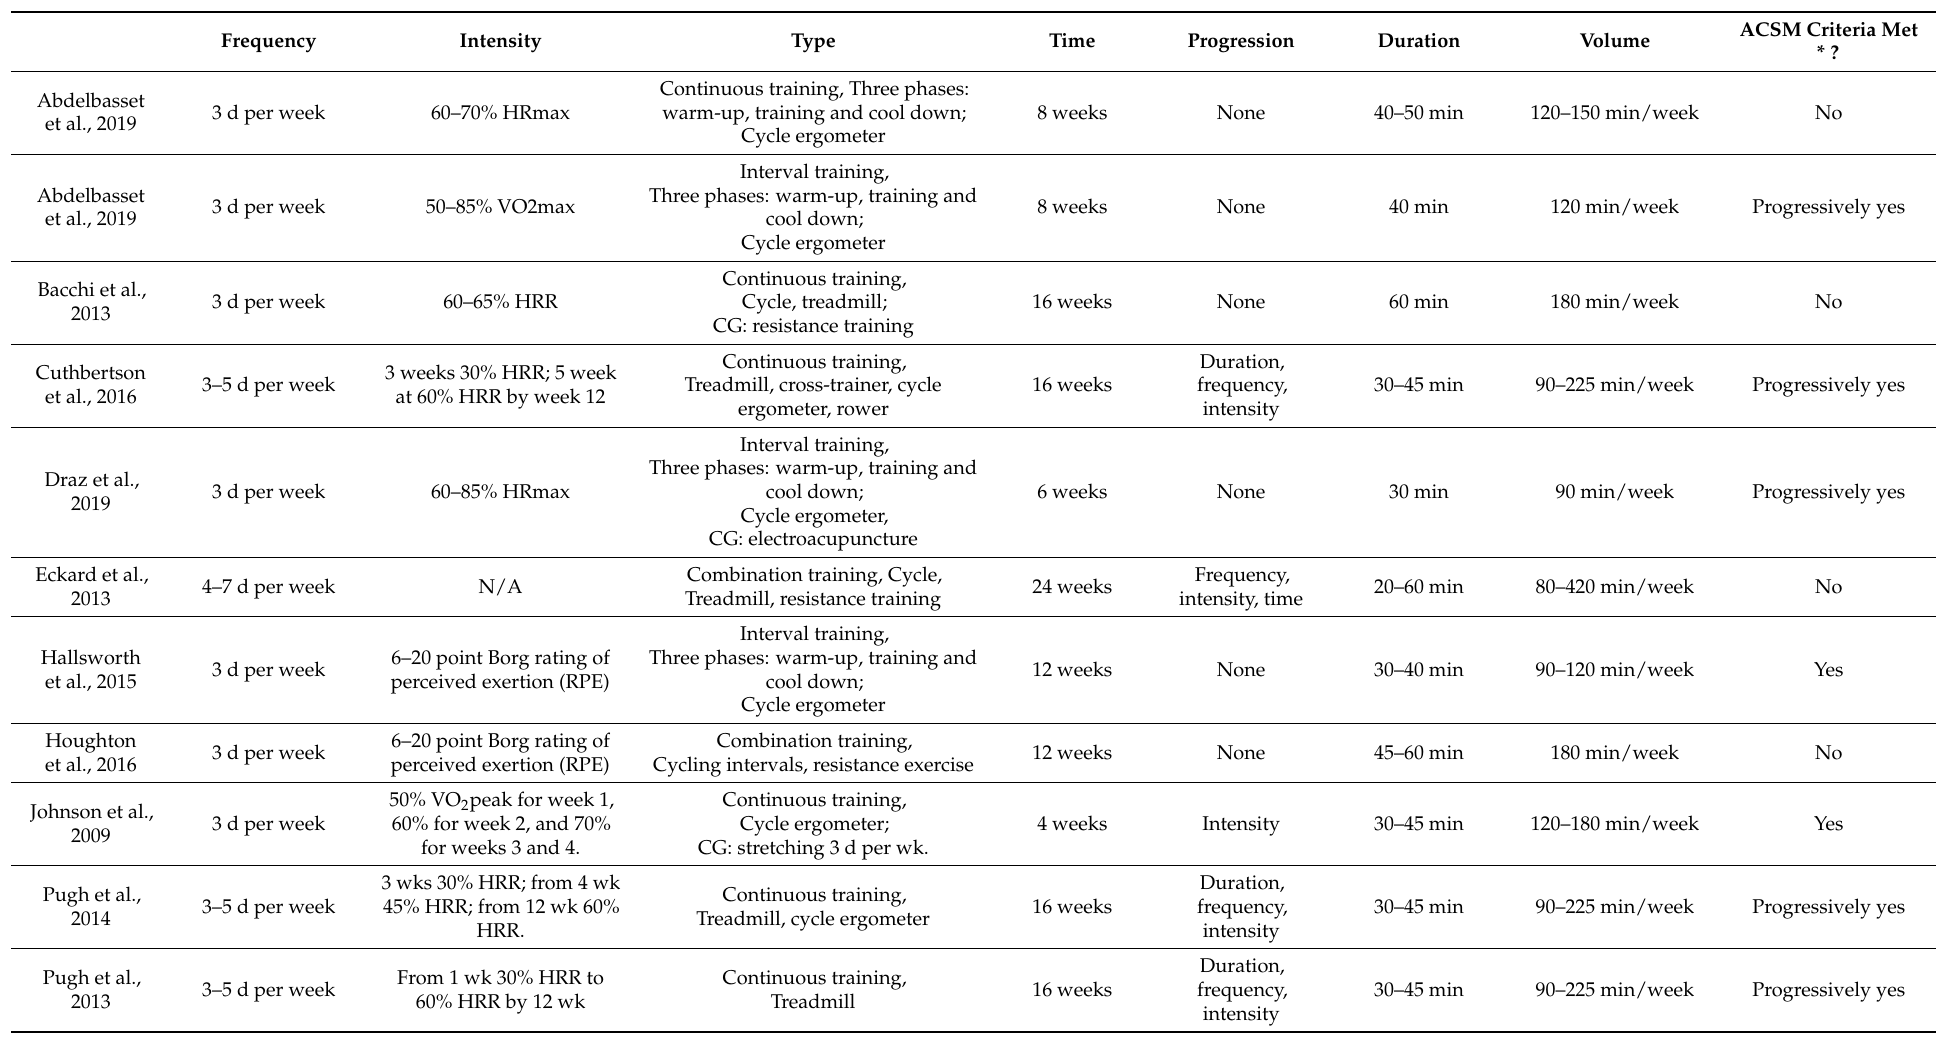
Table 3. Details of aerobic exercise protocols (according to FITT